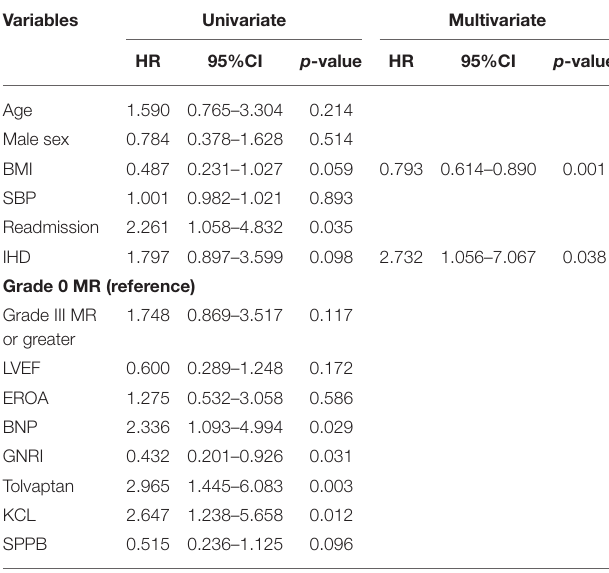
The multivariate Cox proportional hazard regression analysis results were shown using a stepwise variable reduction method described in the Method section. The remaining univariate analysis variables, the p-value larger than 0.20, were listed in Supplementary File 3